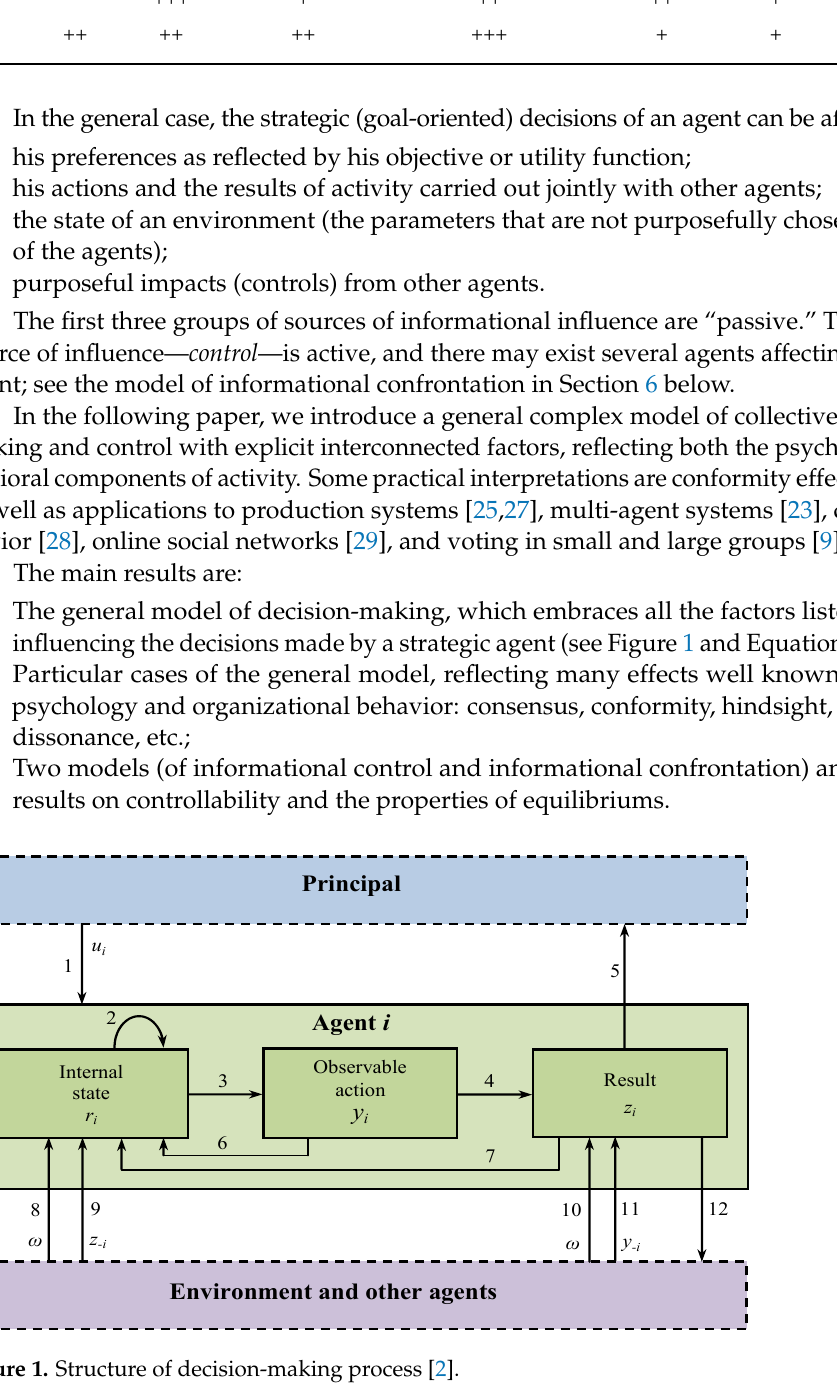
Figure 1. Structure of decision-making process [2].